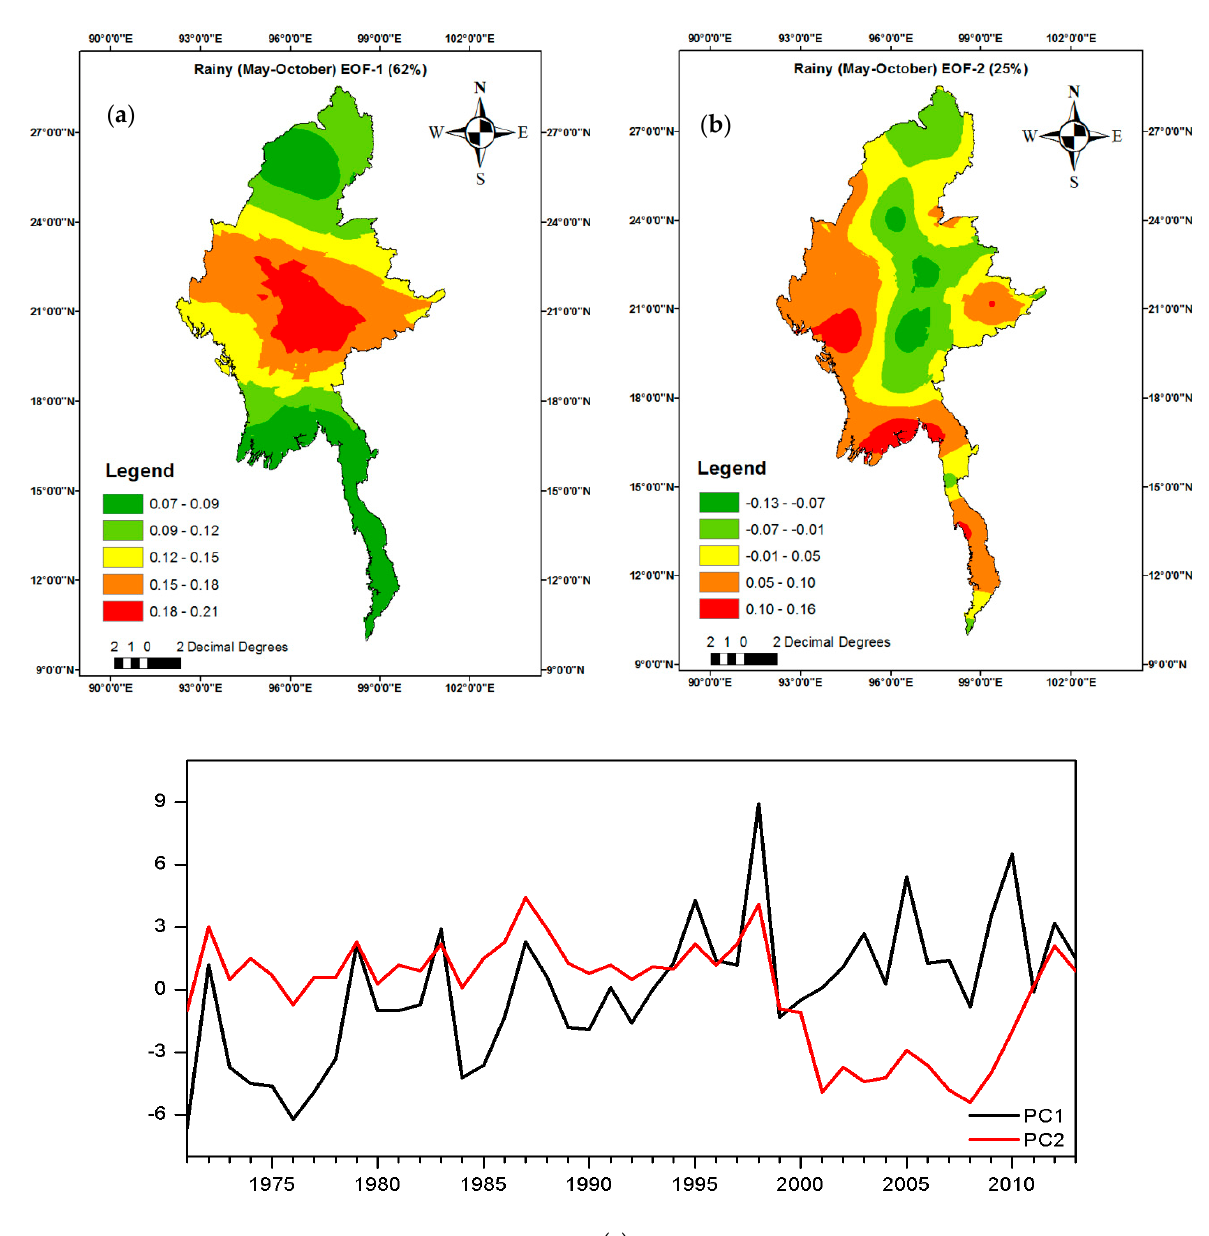
Figure 8. Rainy season (May ‒ October) air temperatures ( a ), the first mode of EOF ( b ), and the second mode of EOF ( c ) with respect to corresponding air temperature of principle components (PC1 and PC2).